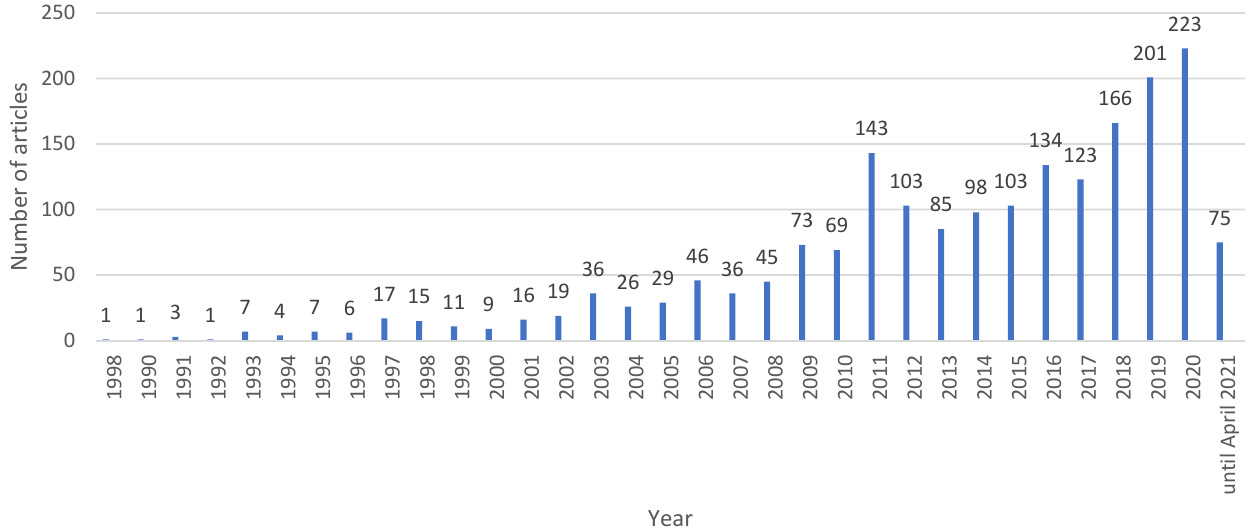
Figure 2. Publications in the SCOPUS database for the query sustainable AND development AND water AND sewage. Source: Own study based on data from Scopus database (accessed on 1 April